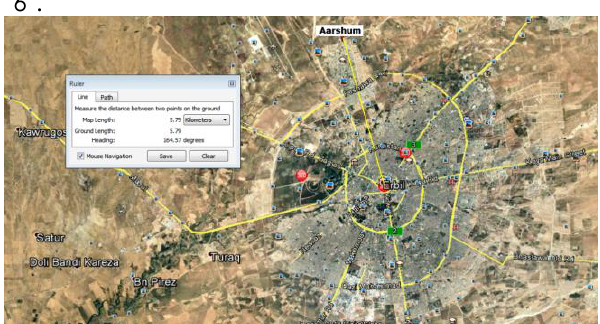
Figure 6. Location of Aarshum Housing Project. Source: (Google Earth, 2017)